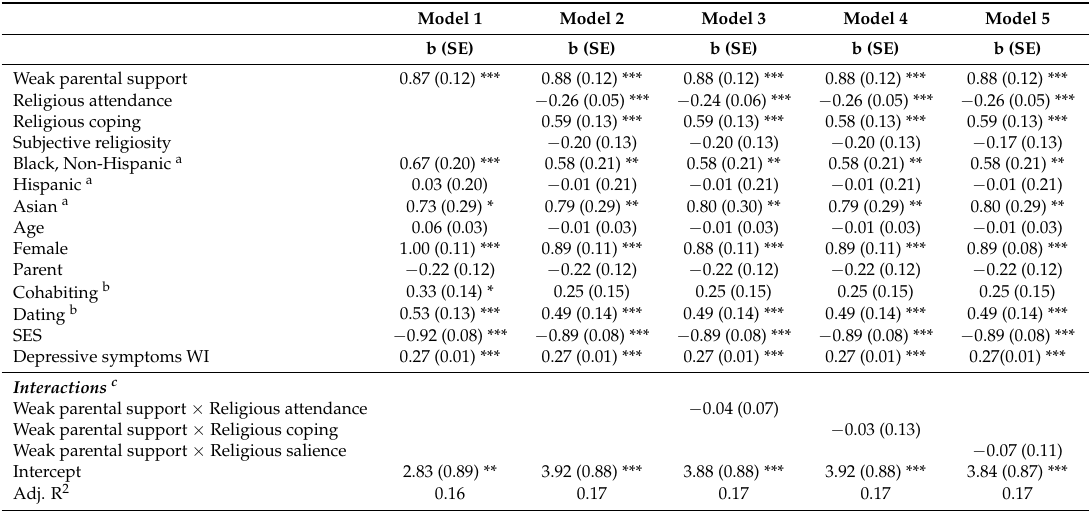
Table 2. Estimated for Weighted Linear Regression Models Predicting Depressive Symptoms, Same-Race (n = 9789), Add